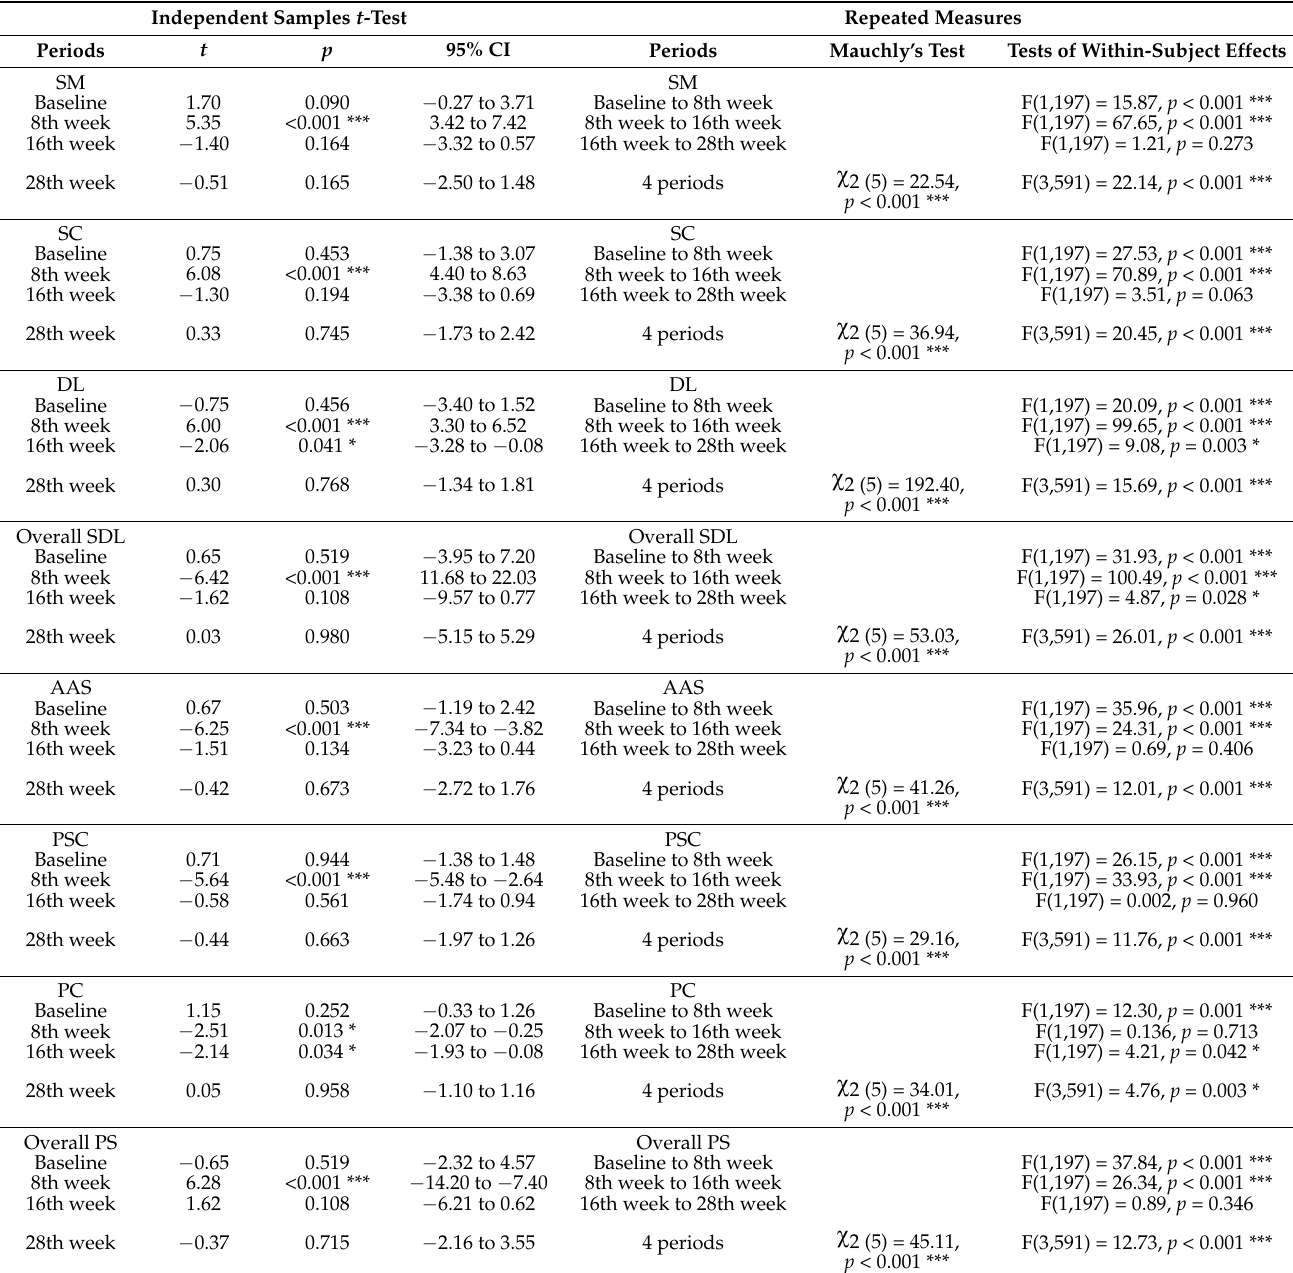
Table 5. Changes of self-directed learning and problem-solving abilities through small group work between two groups at four study periods ( n = 199).